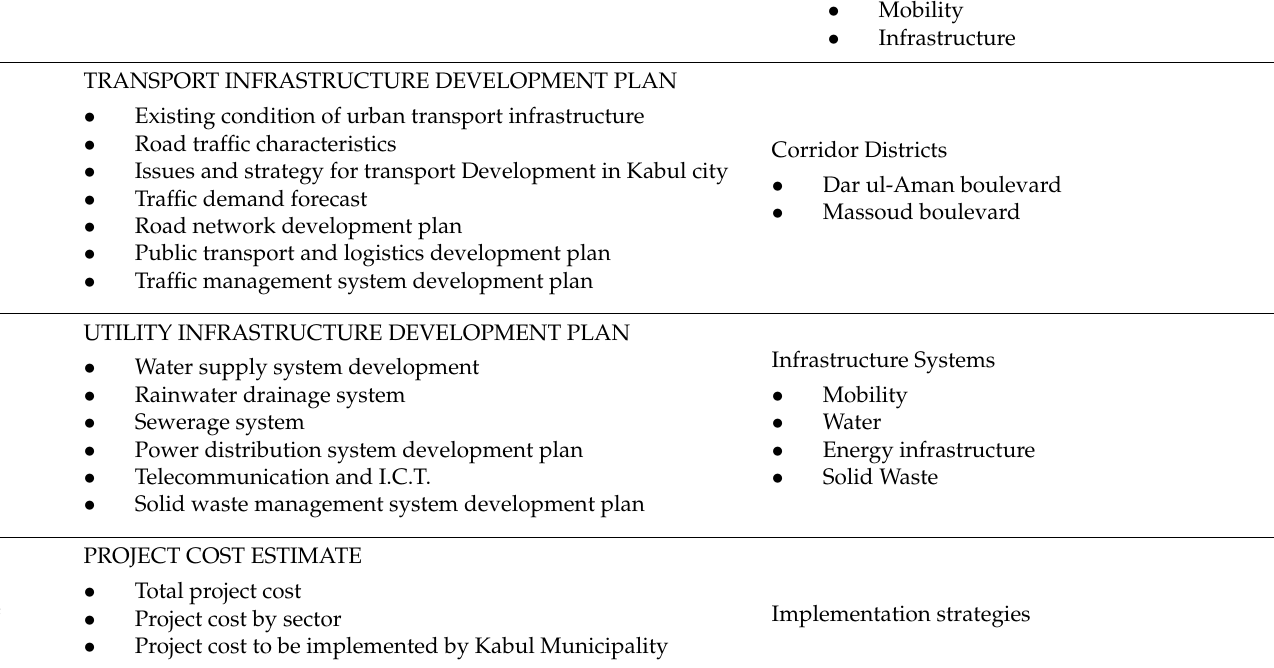
Table 2. Japan International Cooperation Agency (JICA) 2011, and Kabul Urban Design Framework 2018 Master Plans